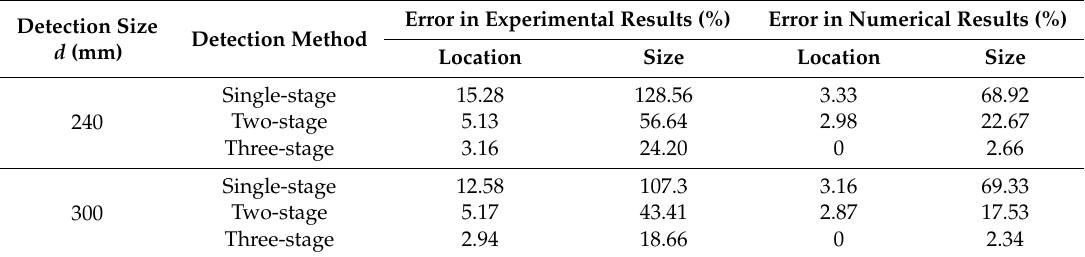
Table 5. Comparison of simulation and experimental results with the actual damage location and size. Detection